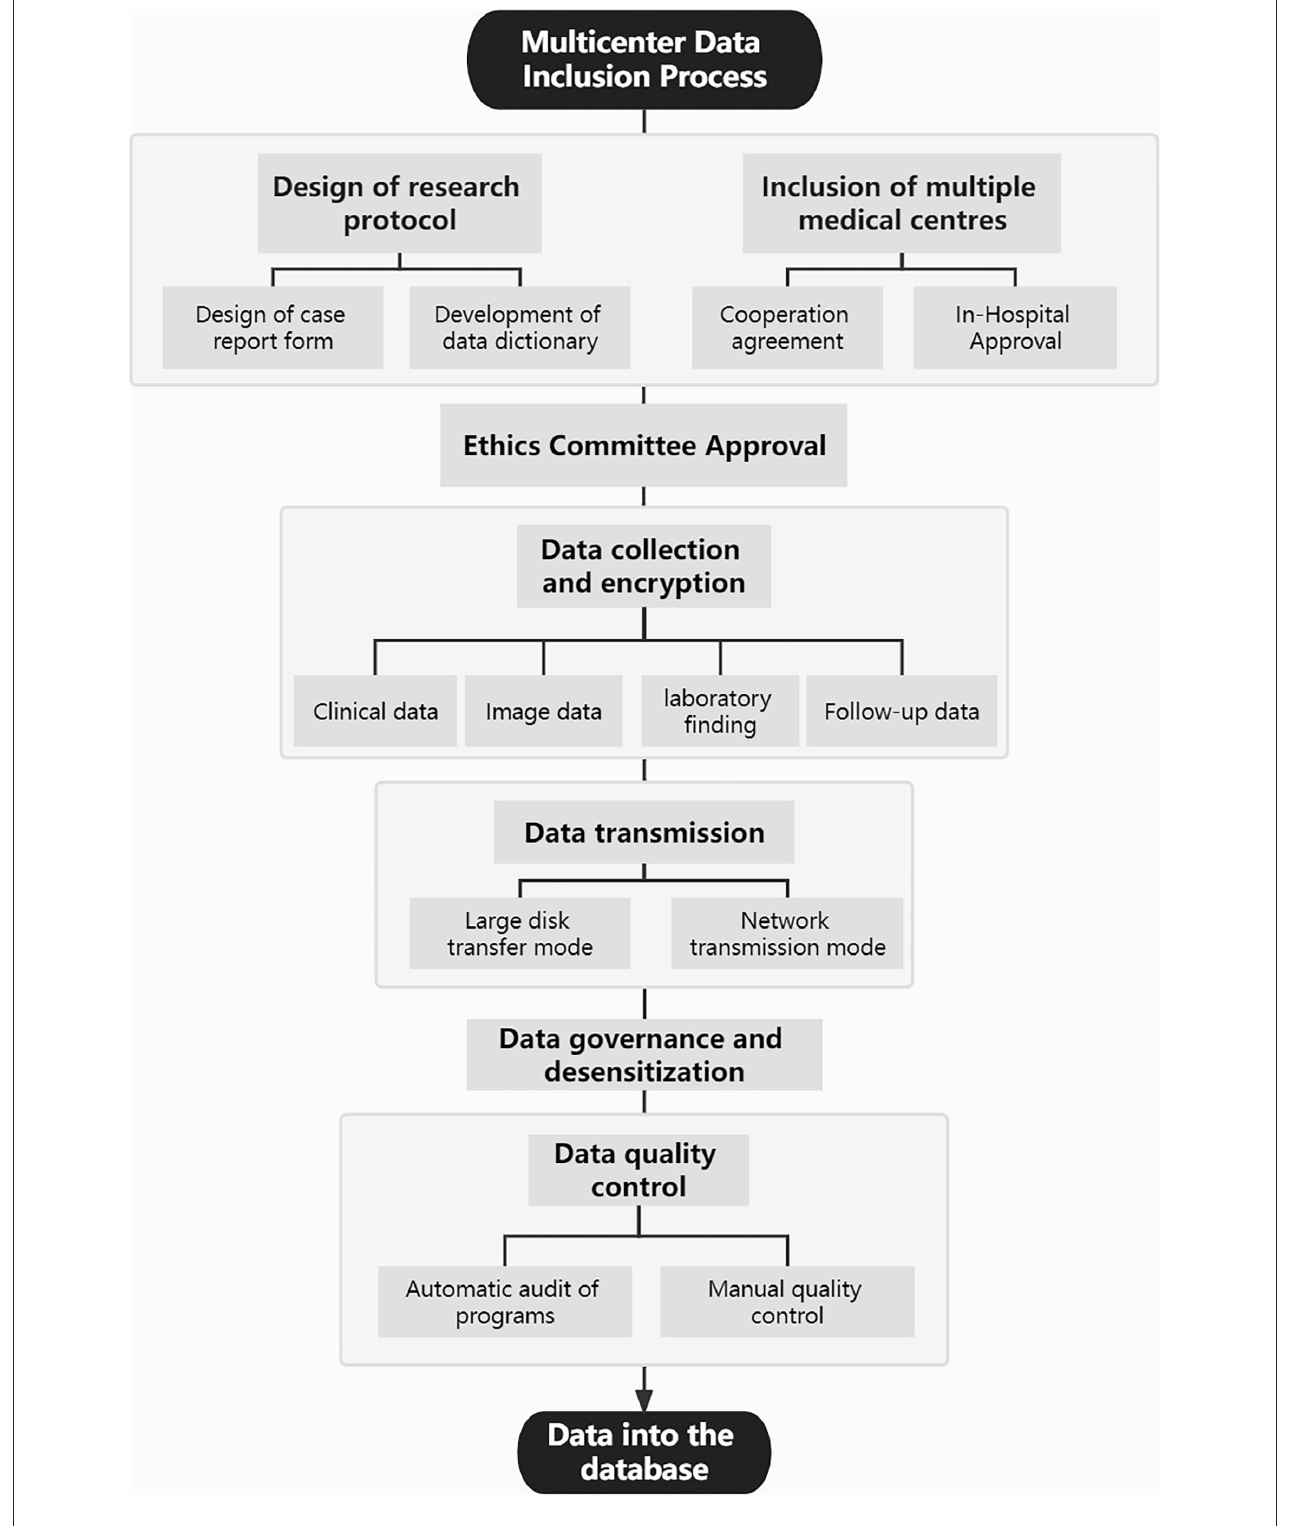
FIGURE 1 | The process of multicenter data